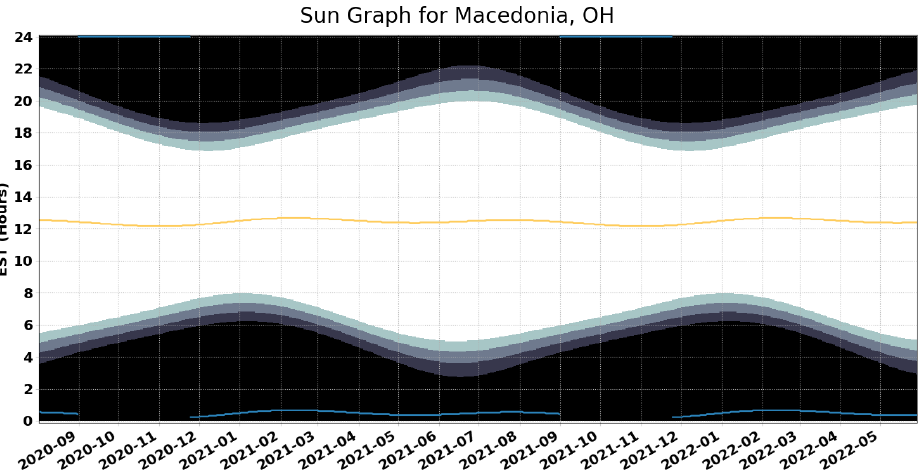
Figure 7. A sun graph showing sunrise and sunset times at the location of Node 7, which corresponds to the measured variation in Fig. 6 (Price-Whelan,